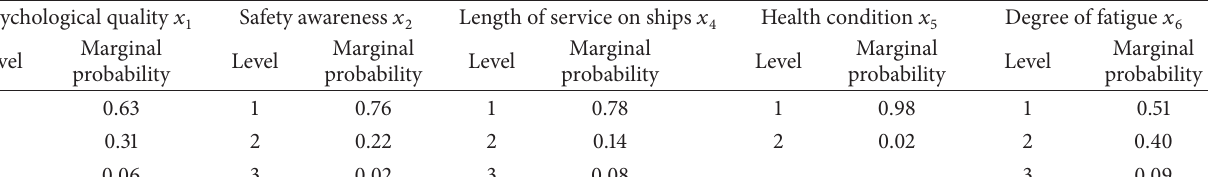
Table 3: Marginal probability of evidence nodes.